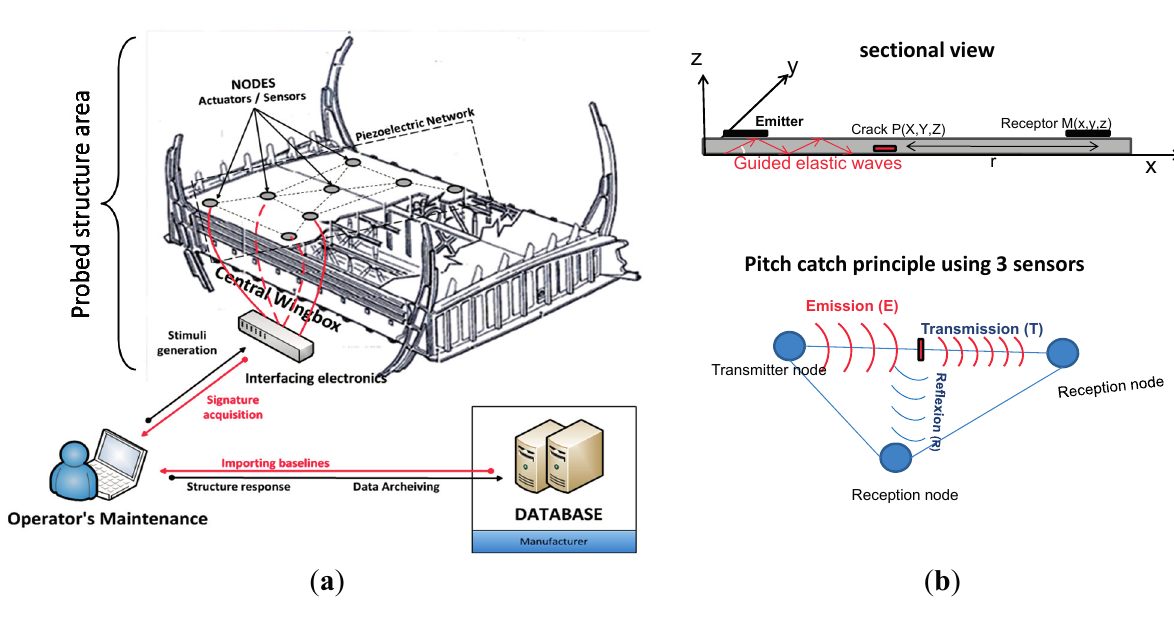
Figure 2. ( a ) Synoptic of the damage diagnosis system; ( b ) Pitch catch technique: one of the used method to extract structures acoustic